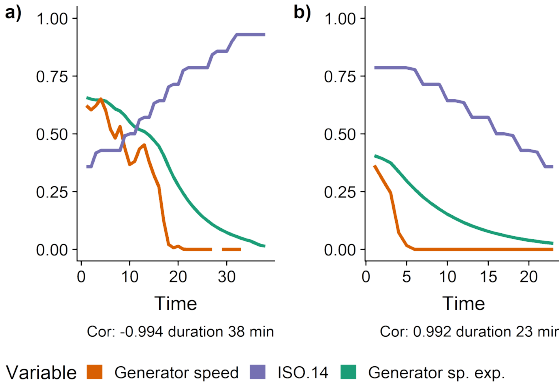
Figure 7. Examples of OSs showing high spearman correlation between ISO.14 and smoothed generator speed. ( a ) Positive correlation. ( b ) Negative